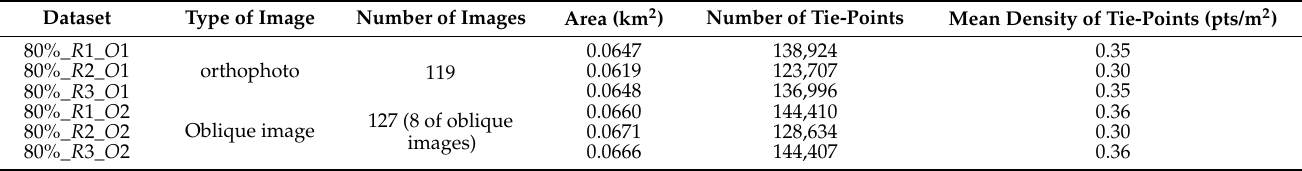
Table 3. Characteristics of datasets resulting from the test